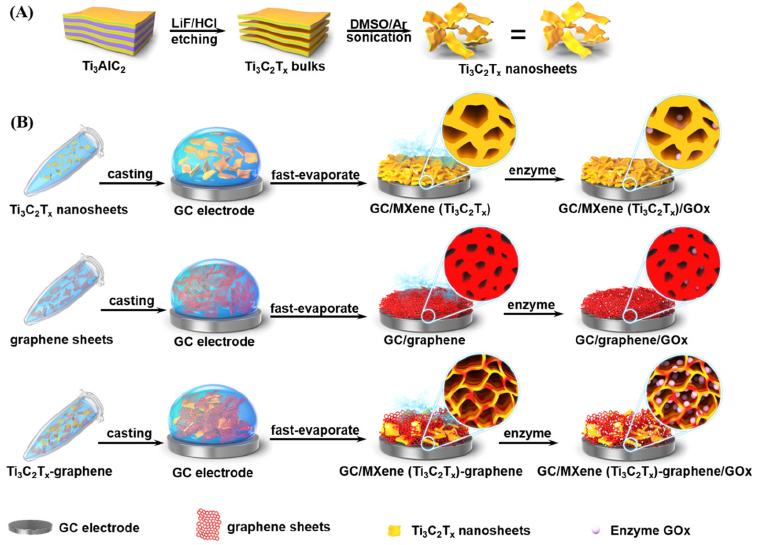
Figure 4. Schematic illustrating the synthesis of ( A ) Ti 3 C 2 Tx nanosheets; ( B ) Ti 3 C 2 Tx Film, Graphene Film, and hybrid of MXene and graphene. Reprinted with permission from Ref.